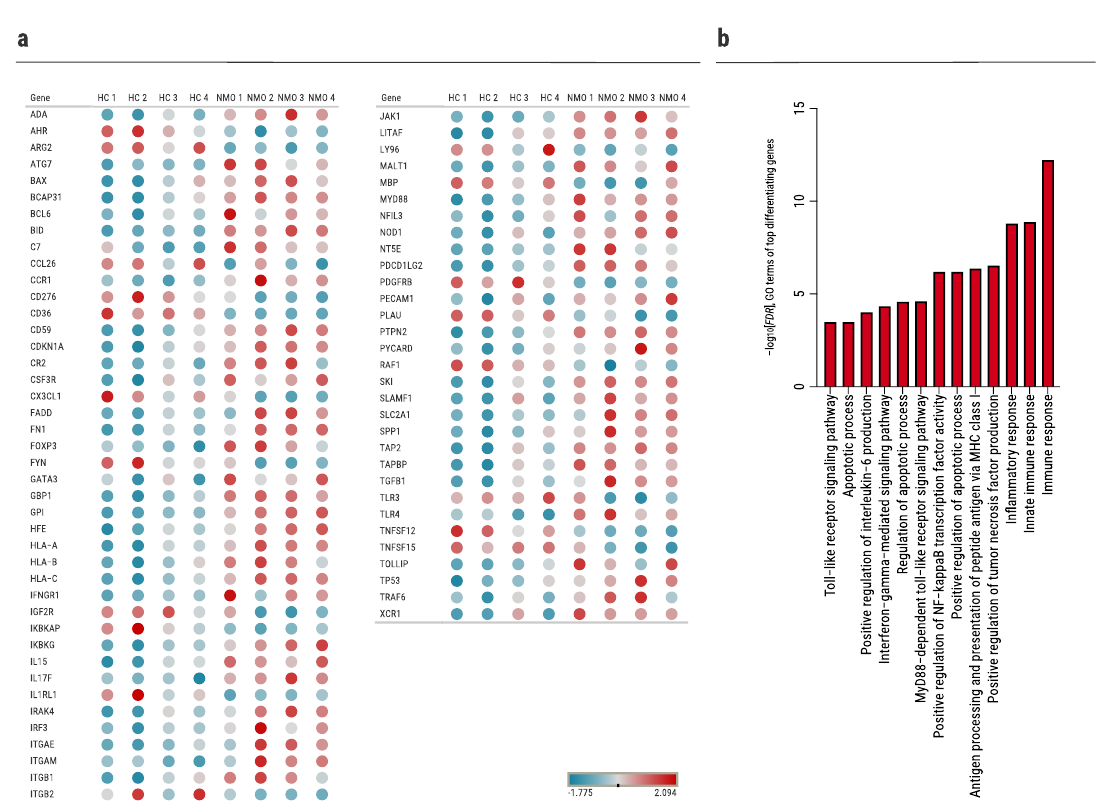
Figure 1. Immunological gene expression profiling in human primary astrocytes cultured with NMO sera. NanoString nCounter analysis of astrocytes cultured with human sera from HCs ( n = 4) and NMO ( n = 4) patients. ( a ) Dot plot illustrating top 73 differentially expressed genes: blue denotes low expression, red denotes high expression (padj < 0.1), ( b ) analysis of top 73 differentially expressed genes in NMO cultured astrocytes versus HC cultured astrocytes. Plot of the top enriched gene ontology (GO) terms (focus on ‘function’ in GOrilla), sorted by –log10[FDR].